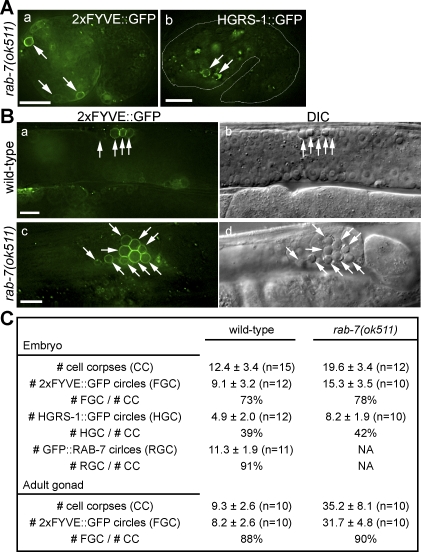
RAB-7 Is Not Required for the Enrichment of PI(3)P on Phagosomal Surfaces or the Incorporation of HGRS-1–Labeled Early Endosomes to PhagosomesScale bars indicate 10 μm. Anterior is to the left. Ventral is to the bottom. Arrows indicate phagosomes containing cell corpses.(A) 2xFYVE::GFP (a) and HGRS-1::GFP (b) signals in 1.5-fold stage rab-7(ok511) (m−z−) embryos. White lines outline the shape of the embryos (b).(B) 2xFYVE::GFP signal in wild-type and rab-7(ok511) (m+z−) gonads of adult hermaphrodites staged at 48 h post-L4.(C) The numbers of cell corpses detected by DIC, 2xFYVE::GFP, and HGRS-1::GFP in gonads of adult hermaphrodites staged 48 h post-L4 and in 1.5-fold embryos. NA, not applicable due to the gfp::rab-7 transgene rescuing the rab-7(ok511) (m−z−) phenotype. Data are presented as mean ± SD. n, number of animals scored.